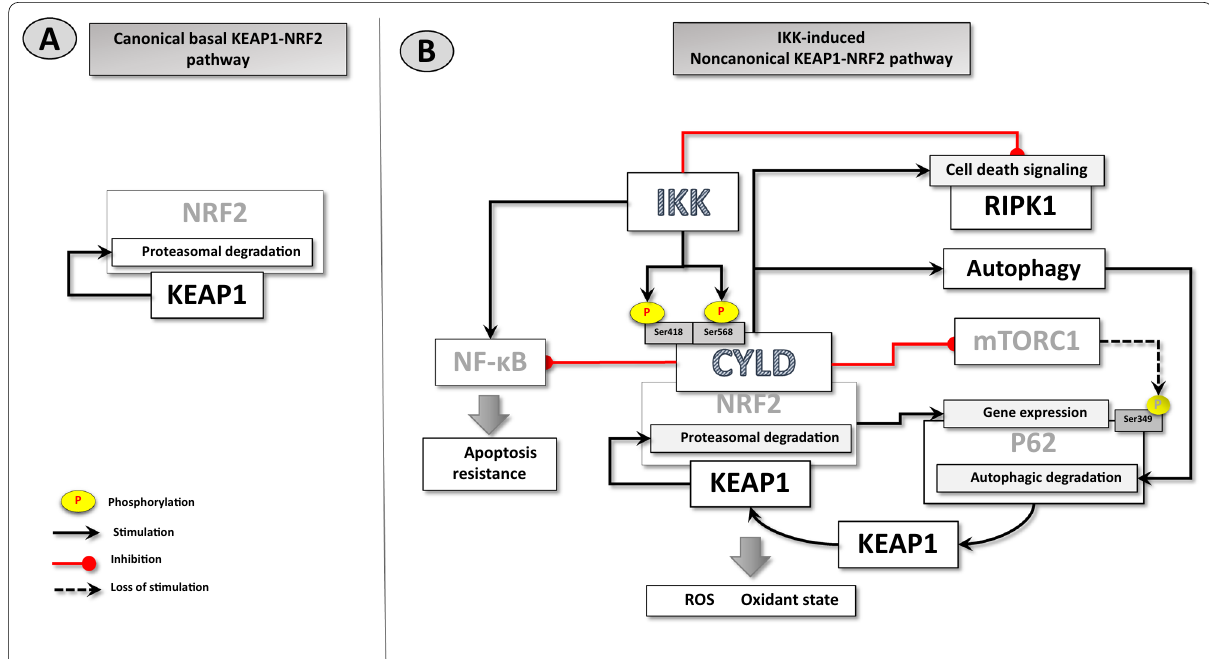
Fig. 1 IKK-CYLD-NRF2 interaction. ( A ): In the resting cell, a low NRF2 level is present due to the canonical KEAP1-NRF2 interaction and degradation. ( B ): Various stimuli that activate the IKK signaling pathway also cause mTORC1 activation and autophagy inhibition. mTORC1 reduces NRF2 degradation by phosphorylating p62 scaffold protein, enhancing the p62-KEAP-1 interaction. However, during the terminal phase of signaling, IKK-mediated phosphorylation-dependent deconjugating activity of CYLD inhibits mTORC1, while stimulating the autophagic pathway. Thus, the resultant mTORC1 inhibition and a decrease in p62 level due to the autophagic degradation results in the loss of the p62-KEAP1 relationship. The liberated KEAP1 degrades NRF2 and inhibits its transcription